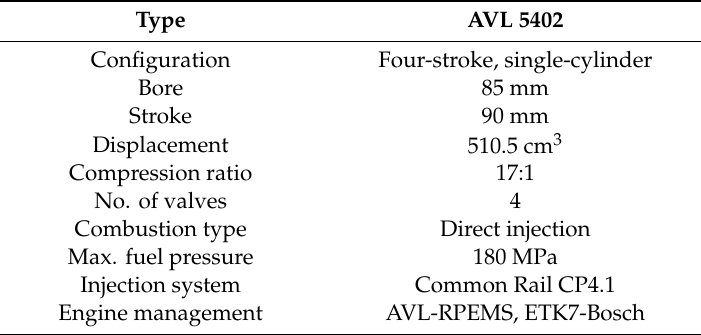
Table 1. Research engine